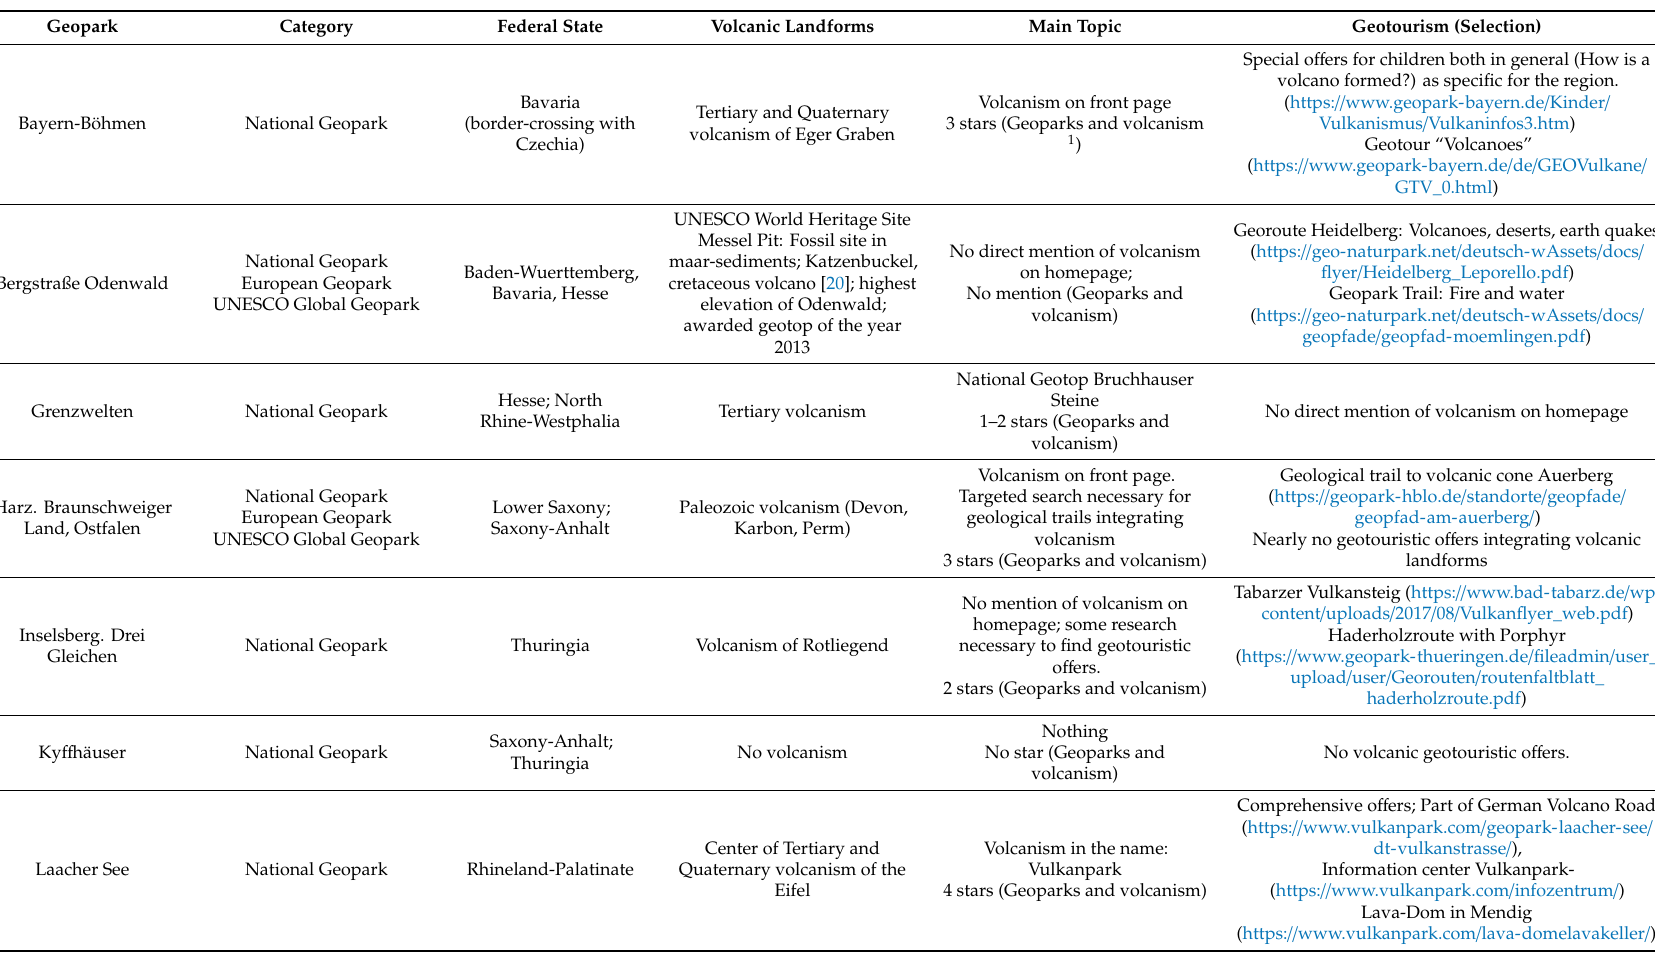
Table 1. National Geoparks and volcanism (Author’s design, based on Homepages of Geoparks, [28,32]). The rating for German Geoparks and volcanism is based on https: // www.geoparks-in-deutschland.de / de / suchergebnis.php?var = Vulkanismus&Zeitalter = #: 4 stars = main topic / unique selling proposition; 3 stars = many or very important volcanic geotouristic o ff ers; 2 stars = some volcanic geotouristic o ff ers; 1 star = subordinate topic; few volcanic geotouristic o ff